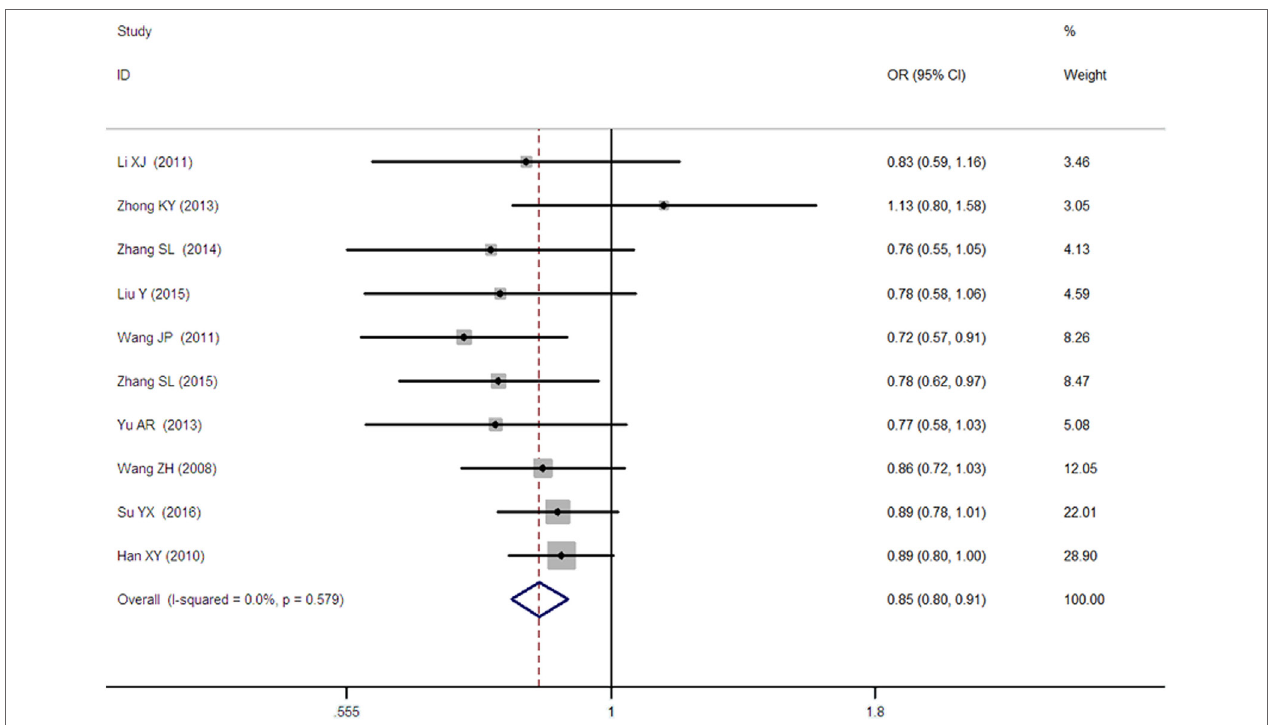
FiGURe 1 | Forest plot of type 2 diabetes mellitus associated with SLC30A8 gene rs13266634C/T polymorphism in the Chinese population under an allelic genetic model (distribution of T allele frequency of SLC30A8